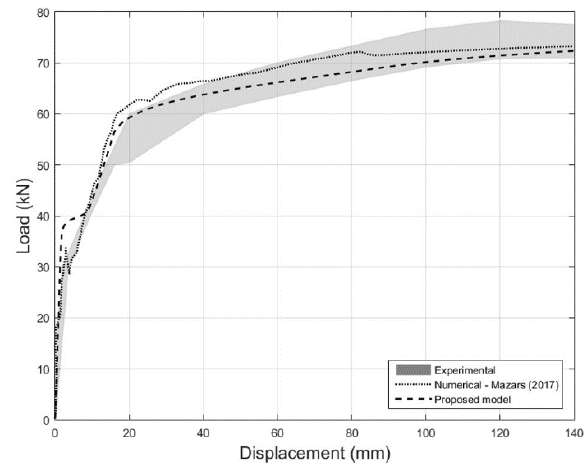
Figure 8. Maximum displacement in the Mazars' beam.